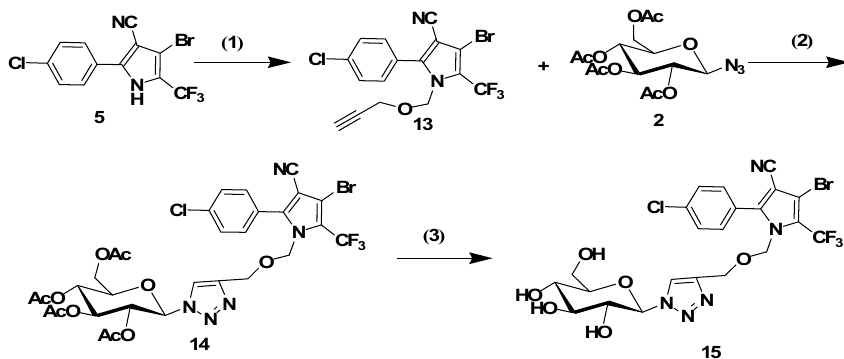
Scheme 4. Synthesis of glucose conjugate 15 with a space arm of methoxymethyl group. Reagents and conditions: (1) THF, Bromochloromethane(10 equiv), NaH, Propargyl alcohol, 65 °C, 48 h; (2) CuSO 4 ·5H 2 O